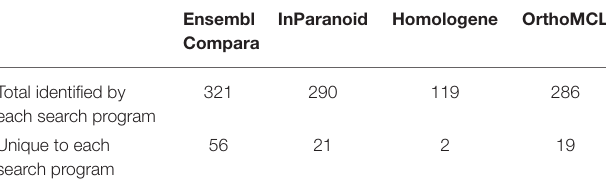
TABLE 4 | Distribution of all 401 AD genes by OrthoList’s four orthology search programs.